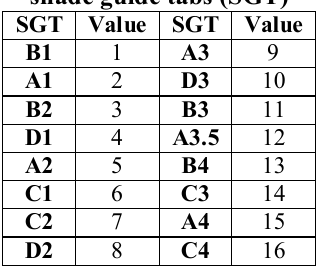
Table 1: Numerical values of Vita classic shade guide tabs (SGT)